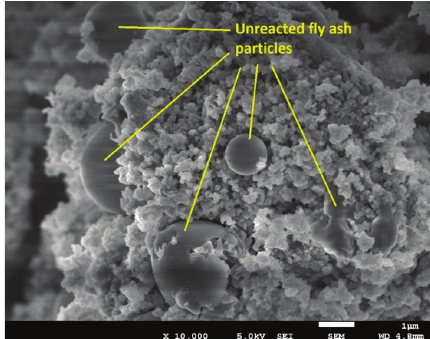
Figure 9: FESEM of ambient-cured OPSGPC incorporating pre- treated OPS with